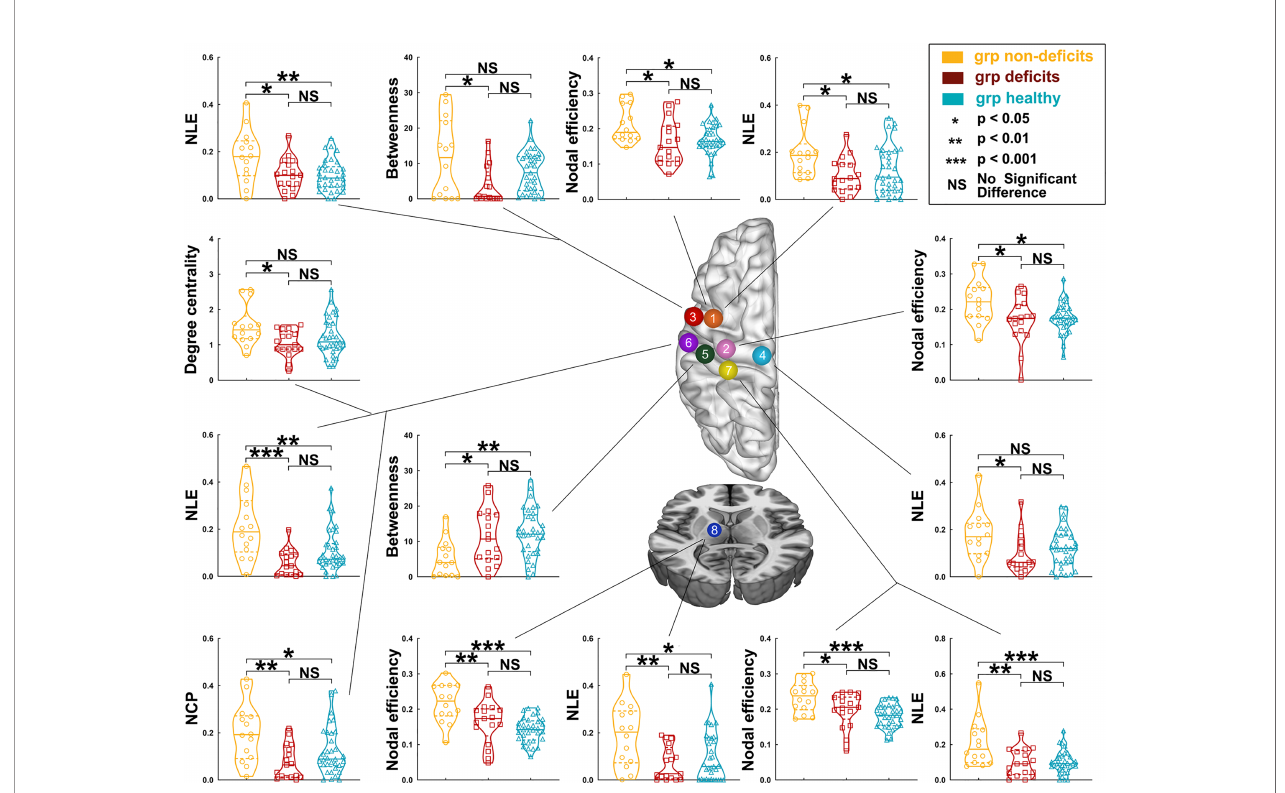
FIGURE 4 | Differences in nodal topological properties of the sensorimotor network in the contralesional hemisphere among the three groups, with right hemisphere glioma. Orange node (No. 1), caudal dorsolateral Brodmann area (BA) 6 (A6cdl); pink node (No. 2), upper limb of BA 4 (A4ul); red node (No. 3), tongue and larynx of BA 4 (A4tl); light blue node (No. 4), lower limb region of BA 4 (A4ll); green node (No. 5), upper limb, head, and face regions of BA 1/2/3 (A1/2/3ulhf); purple node (No. 6), tongue and larynx of BA 1/2/3 (A1_2_3tonIa); yellow node (No. 7), trunk region of BA 1/2/3 (A1_2_3tru); and dark blue node (No. 8), premotor-related thalamus